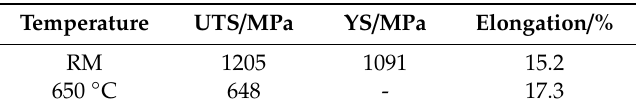
Table 2. Mechanical properties of alloy TC31 with the thickness of 3 mm at room temperature and high temperature 923